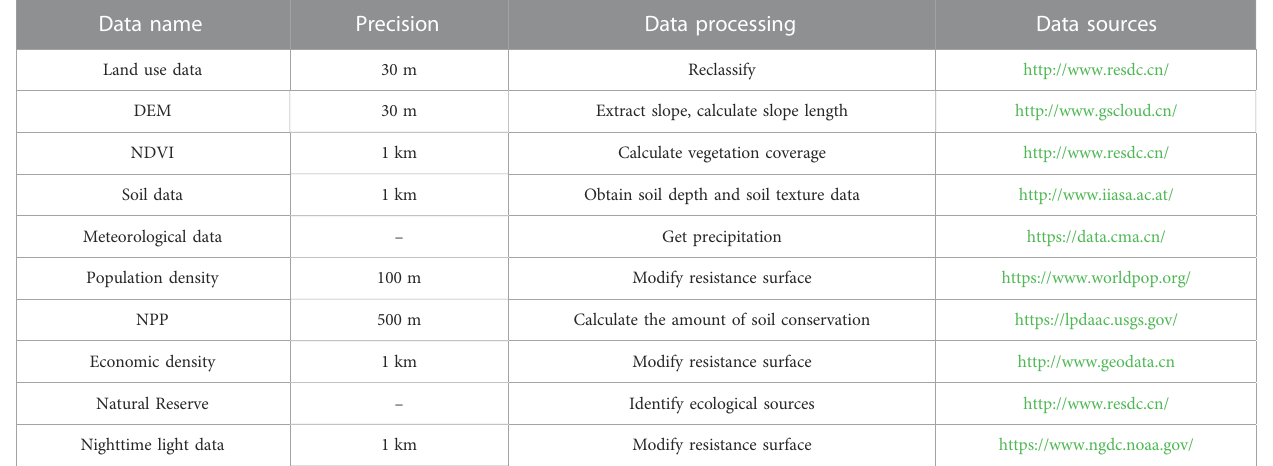
TABLE 1 Description of the